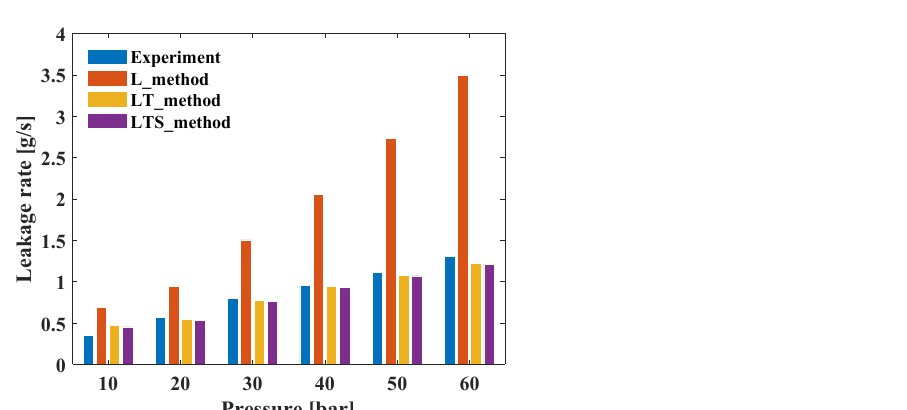
Figure 6. Experimental setup to measure leakage rate.